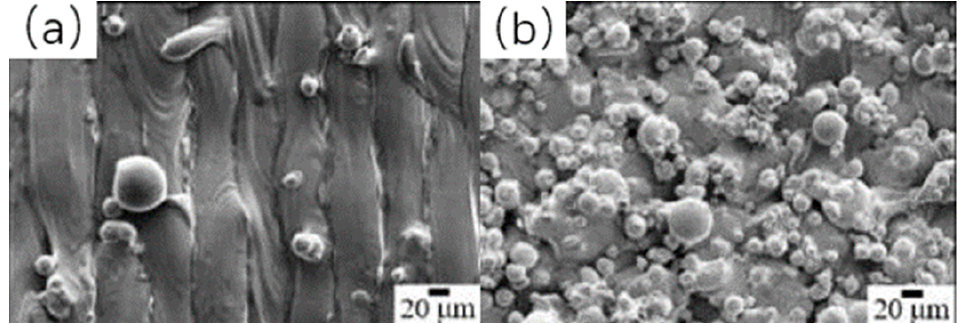
Figure 3. SEM images of the top surface ( a ) and side surface ( b ) of the sample.